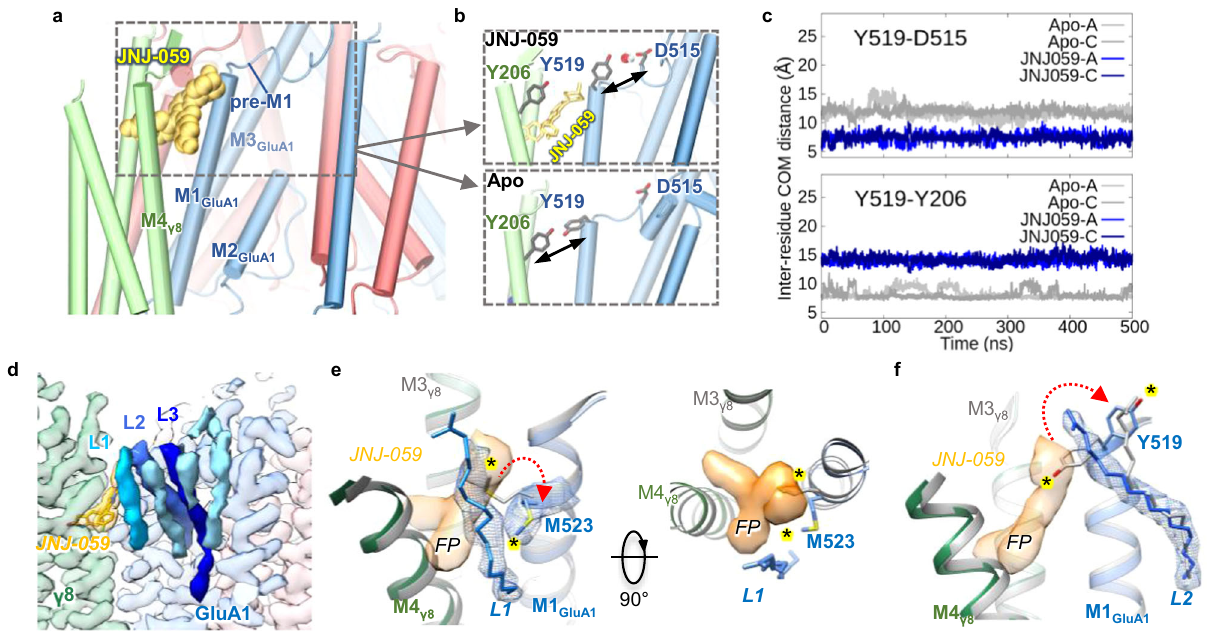
Fig.3|JNJ-059-inducedH-bondformation,andlipidinteractions.a Modelofthe receptor complex with JNJ-059 (yellow spheres), highlighting the proximity betweenthe NAMpocketand the GluA1pre-M1 helix (the fi gureis derivedfrom an MDsimulation). b JNJ-059disruptsTyr519interactionwithTyr206( γ 8)(toppanel), ascomparedtoasimulationwithouttheNAM( ‘ Apo ’ ;bottompanel),butenablesan H-bond between Tyr519 and Asp515 in the pre-M1 helix (top). c Variations in dis- tance between centres of mass for Tyr519-Asp515 and Tyr519-Tyr206 in MD simu- lationsofresting-statemodels.Distancesarecomparedfortheapostate(grey)and the JNJ059-bound structure (blue). Data are for both GluA1 subunits (chains A